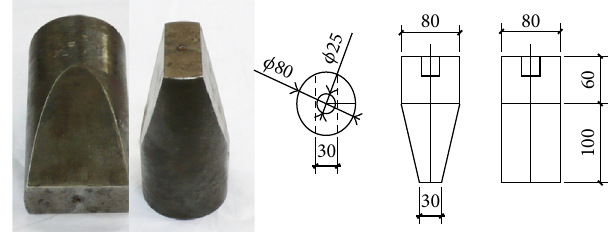
Figure 3: Shape and size of drop hammer.